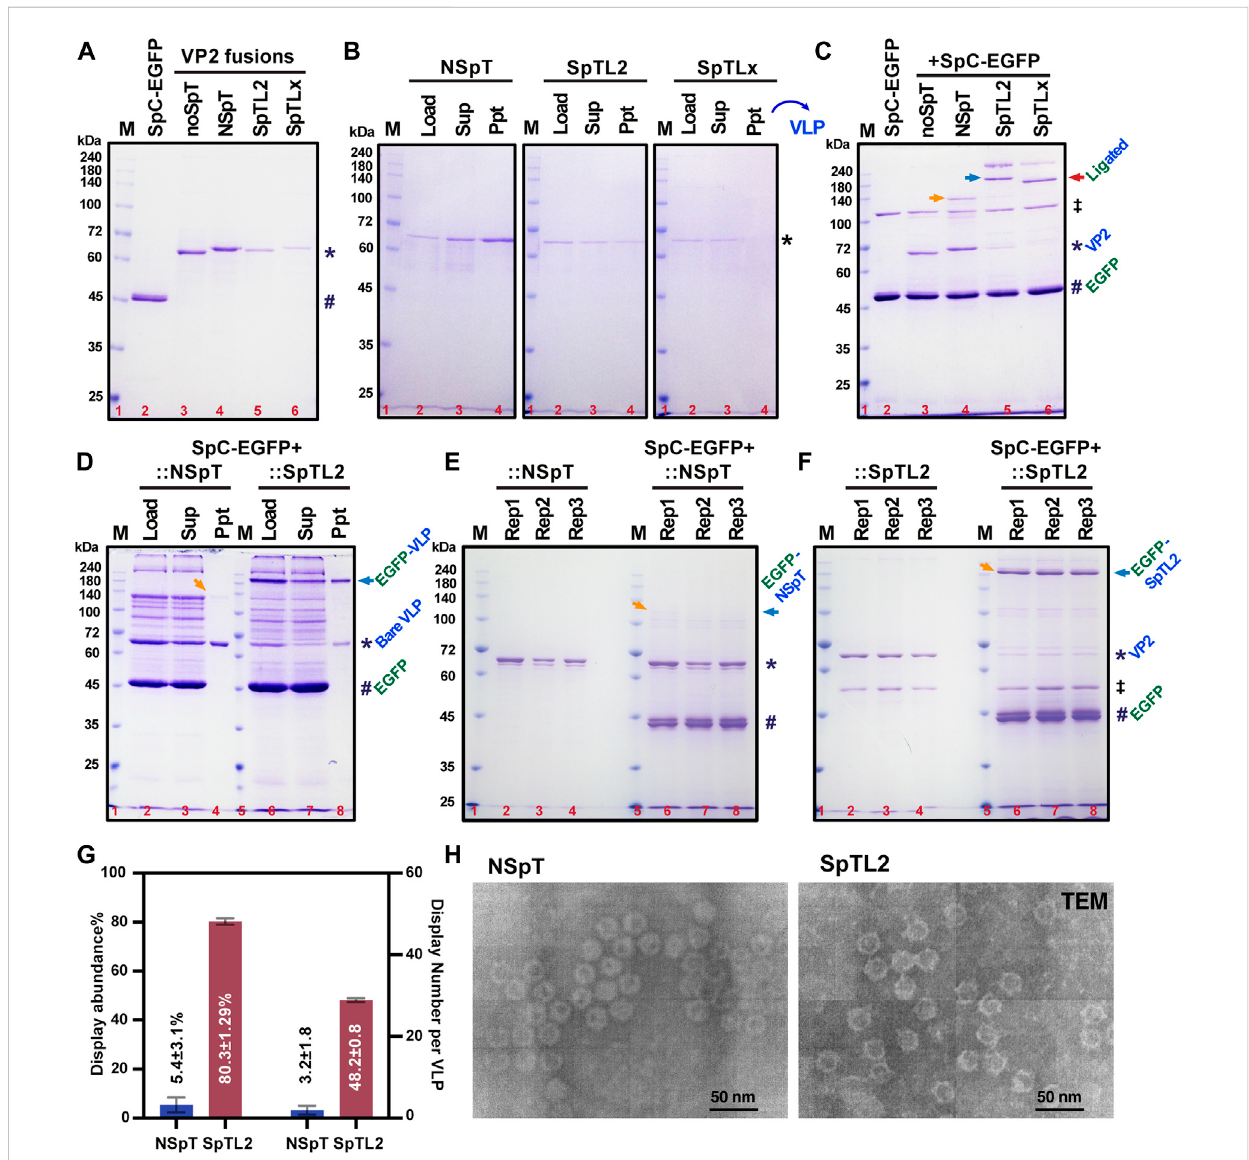
FIGURE 3 Veri fi cation of enhanced protein display in SpT-inserted VP2-derived VLPs. All SpC-EGFP and VP2 without SpT (noSpT) or with SpT at N-terminus (NSpT), Loop2 (SpTL2), and LoopX (SpTLx) were expressed and puri fi ed from the fat body of each recombinant baculovirus-infected silkworms (A) . VLP formation and puri fi cationwereperformedthroughultracentrifugationwitha20%sucrosecushion (B) . Invitro covalentbindingef fi ciencybetweenSpC(#)andSpT(*)variants wasvalidatedusingsaturatedSpC-EGFP(#)proteinsasindicatedin (C) .Ligatedadductsweremarkedwitharrows.Thedoubledagger( ‡ )symbolwasusedto indicate an impurity from the puri fi cation of SpC-EGFP. Reaction products between SpC-EGFP and VP2 variants, NSpT and SpTL2, were further subjected to ultracentrifugationwith20%sucrosesolution.VLPproducts,witherbareVLP(*)andEGFP-decoratedVLP(EGFP-VLP,arrow),wereshowninCBB (D) .Thebinding assay was repeated three times (E,F) , and the precipitations showing the relative amount of EGFP-VLP were statistically analyzed and summarized in (G) , which demonstratedanapparentincreaseofEGFP-displayedVLPfromabout5.4%(3perVLP)to80%(48perVLP).Thedoubledagger( ‡ )symbolwasusedtoindicatean impurity from the puri fi cation of SpTL2. The VLP formation for NSpT and SpTL2 variants were validated in TEM (H)